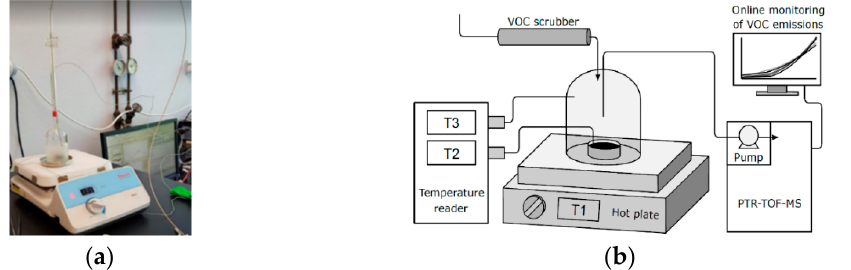
Figure 2. Measurements of volatile organic compounds (VOCs) from a bitumen sample: ( a ) the experimental setup and ( b ) its simplified scheme (T1: hot plate thermometer, T2: thermocouple sensor monitoring bitumen temperature, T3: thermocouple sensor monitoring chamber temperature).